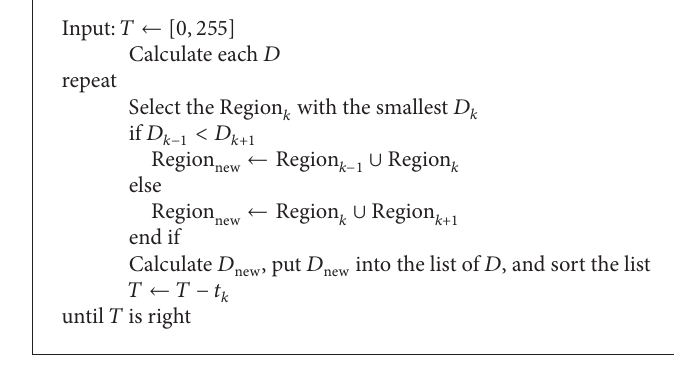
Algorithm 1: Histogram region merging.